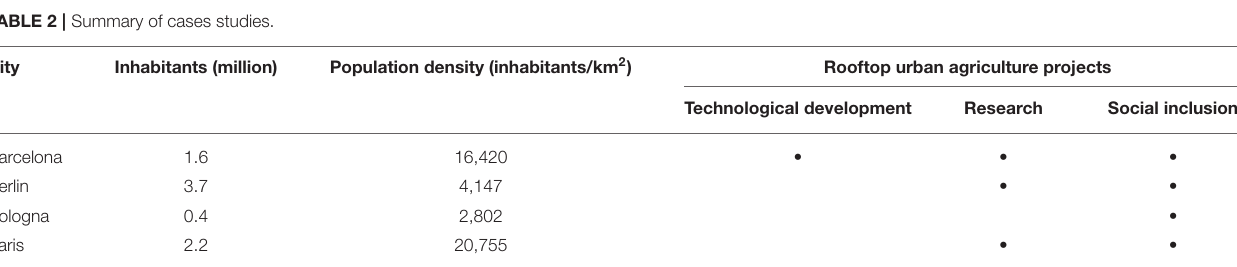
TABLE 2 | Summary of cases